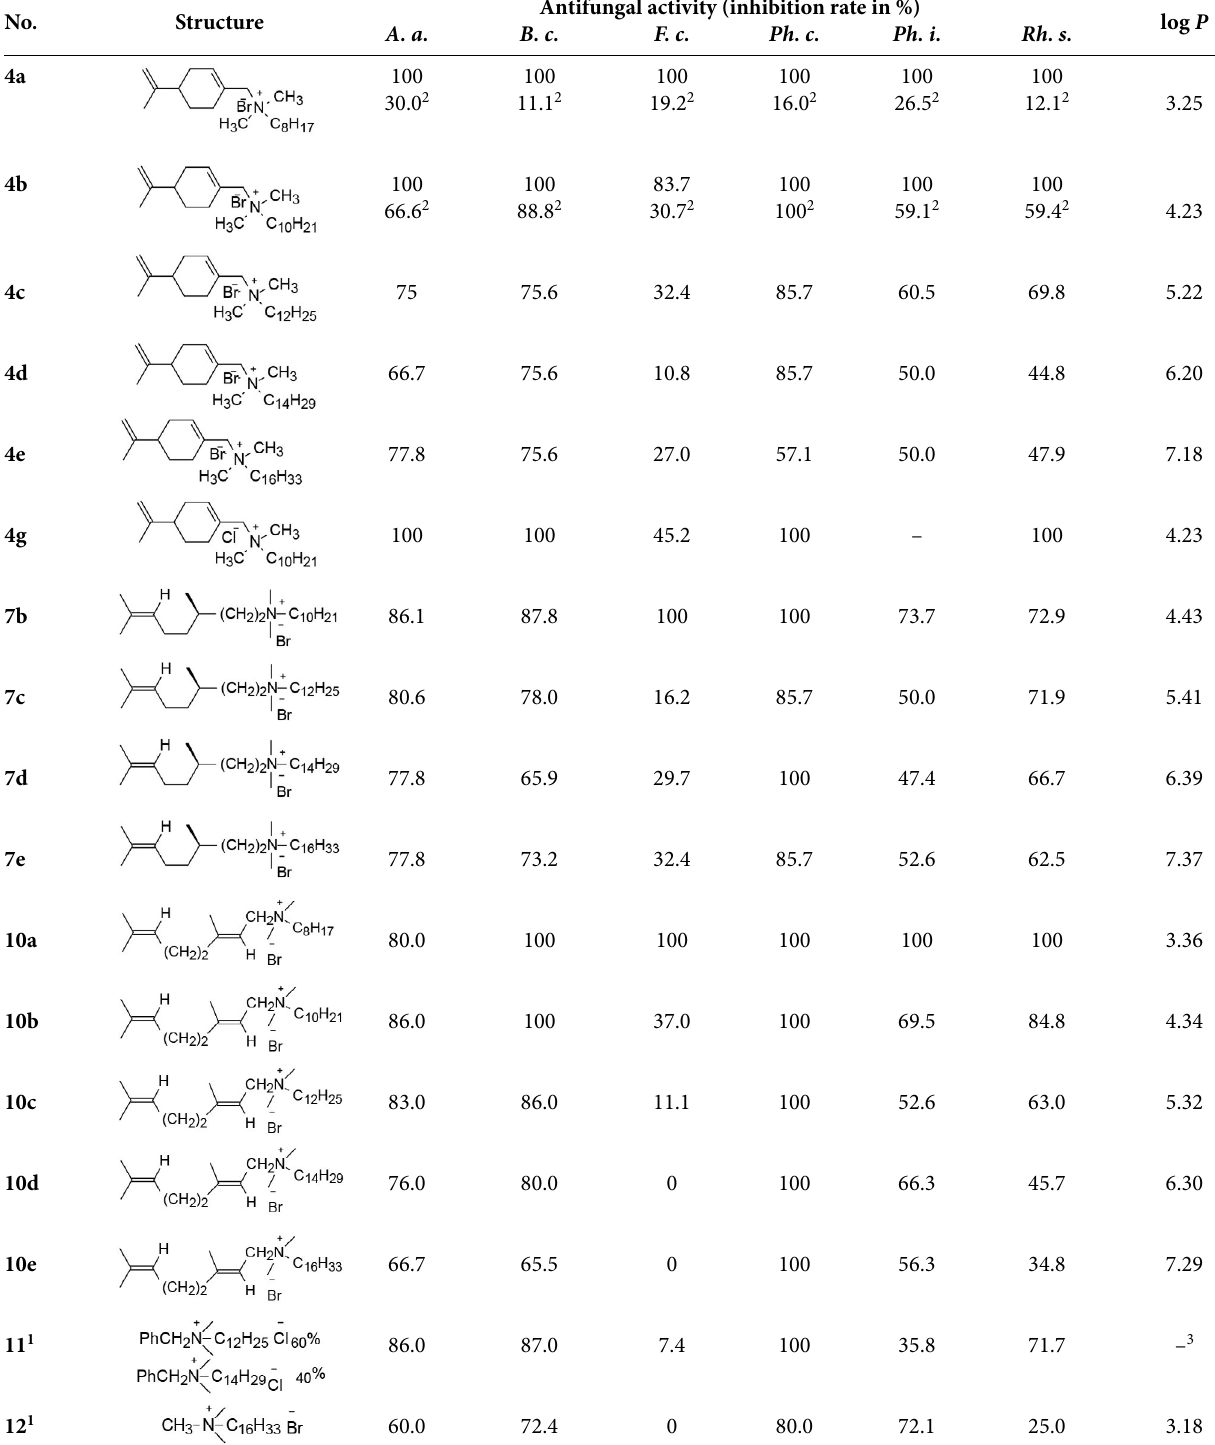
Table 1. Antifungal activity of compounds 4a – h , 7a – e and 10a – e against plant pathogens in vitro at conc. 200 mg/L No.